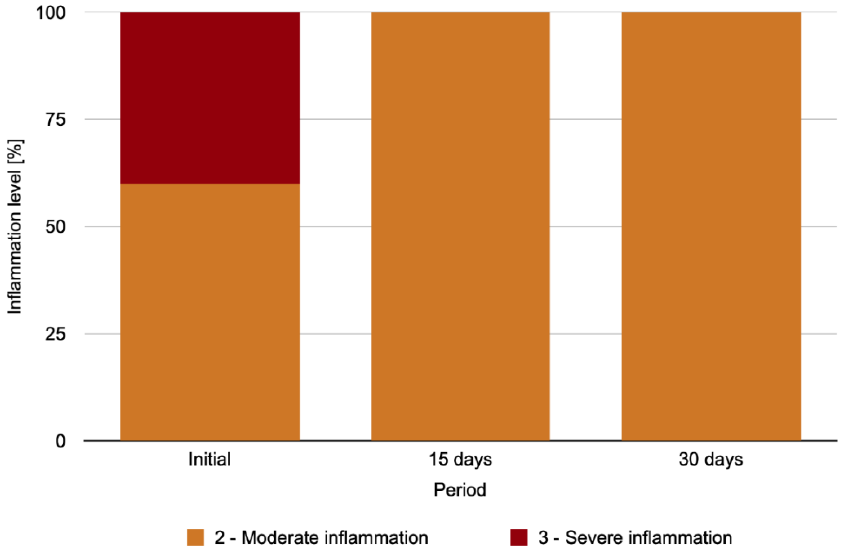
Figure 5. Percent distribution of the level of palpebral conjunctiva inflammation in the anophthalmic socket over time in the